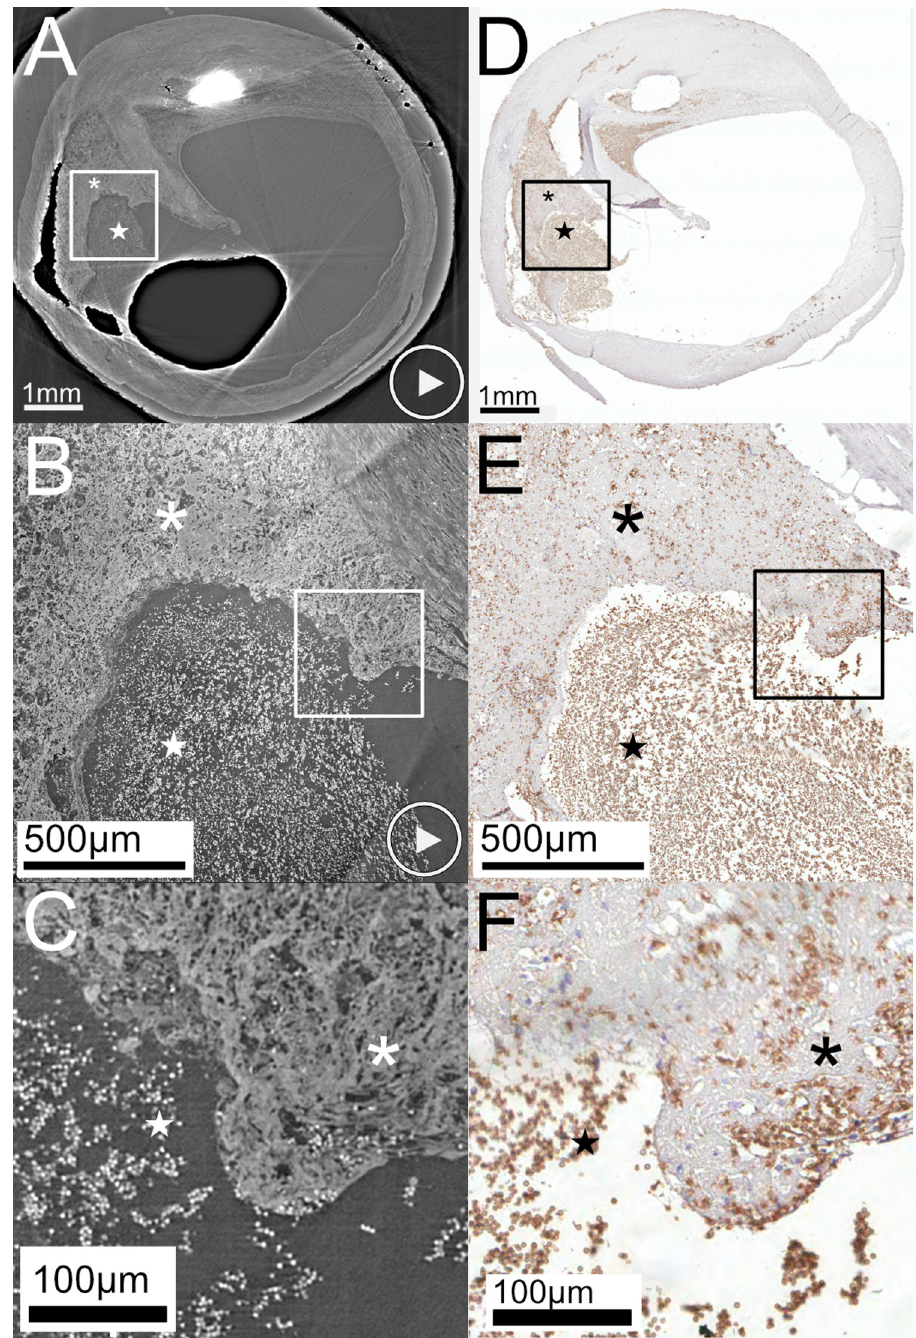
Fig 2. Rupture with plaque tissue exposed to the bloodstream with thrombus formation. (A) LR SR μ CT of a ruptured shoulder region with plaque tissue (asterisk) exposed to the bloodstream with the formation of a thrombus (star). (B) the zoomed-in area of the interface between plaque tissue and thrombus, obtained with HR SR μ CT. The white square in (A) corresponds to the area in (B) . (C) shows the area of the white square in B with the zoomed-in region of the plaque tissue (asterisk) and thrombus (star) interface. Individual erythrocytes are also seen scattered within the exposed plaque tissue, which is also seen in histology (D-F). The corresponding section in histology, stained for erythrocytes (Glycophorin A), is seen in (D) , with the black squares marking zoom-in regions in (E) and further in (F) . The black asterisk indicates plaque tissue and the black star marks the thrombus. The "play" symbols in (A) and (B) indicate related movie material, showing the LR (S4 Movie in S1 File) and HR (S5 Movie in S1 File) tomographic image stacks. Plaque ID 1 in S1 Table in S1 File.